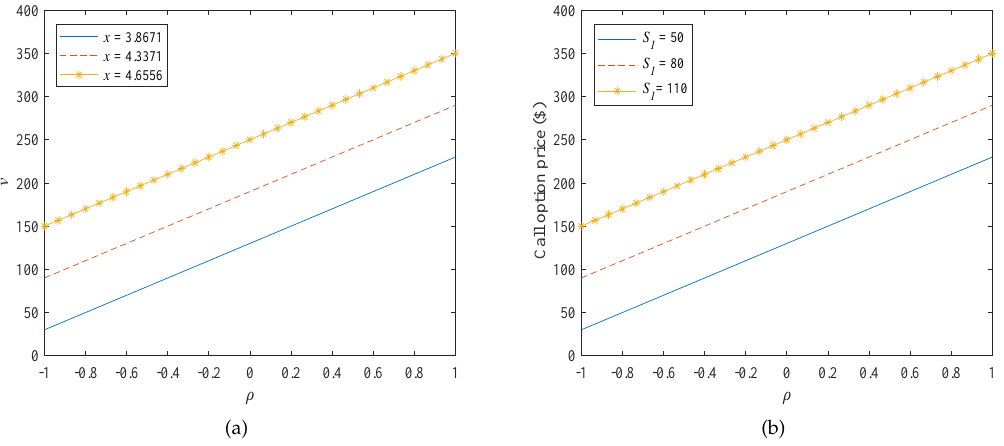
Figure 6. Relationship between the European call option and the correlation ρ for time derivative order α = 0.9 at a day before the expiration date: ( a ) v for y = 1.6093 and ( b ) c for S 2 =